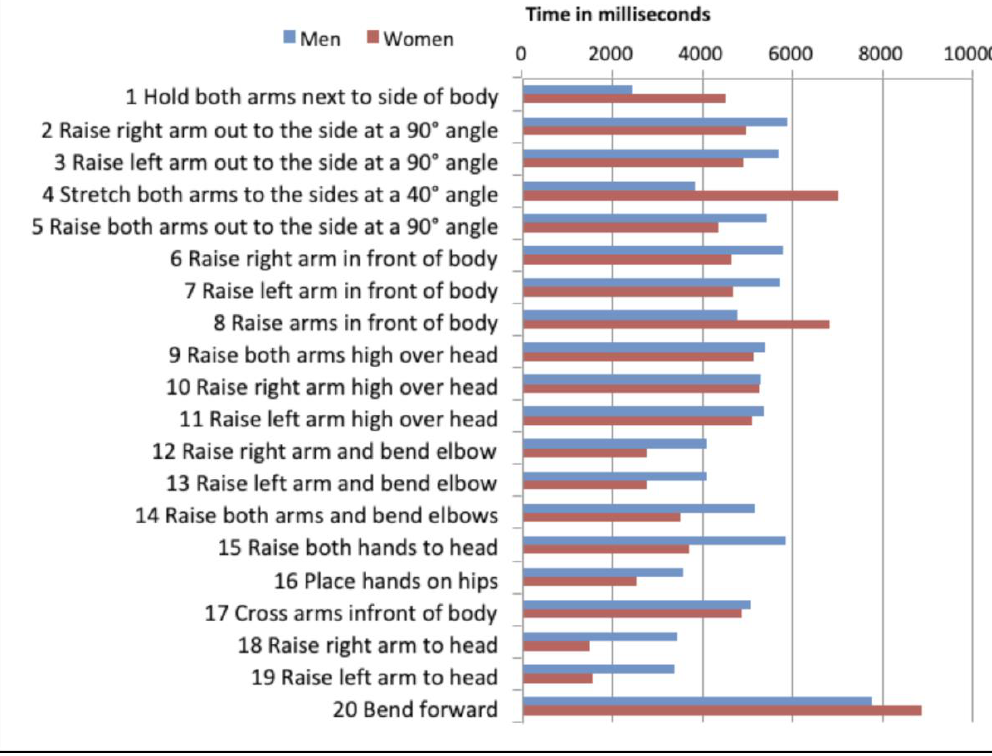
Figure 9. Gestures by execution time and gender.